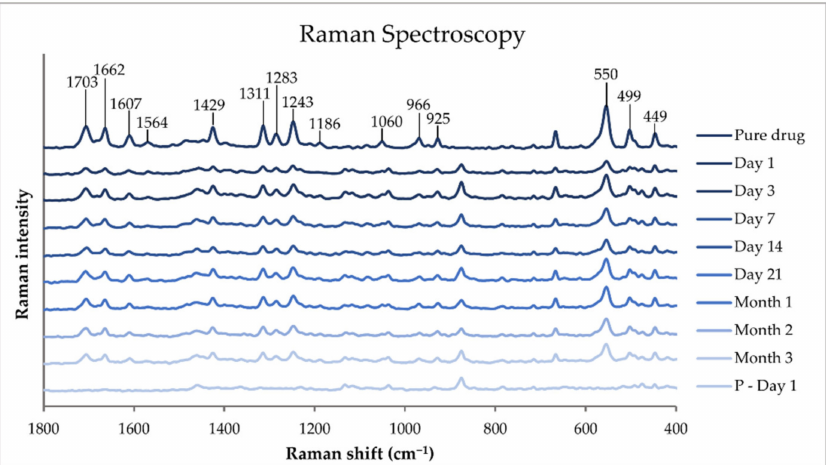
Figure 8. Raman spectra of pure theophylline and drug-loaded printed ChewTs were measured at the different stability study time points, and drug-free placebo (P) extrudate was measured on day 1 of the stability